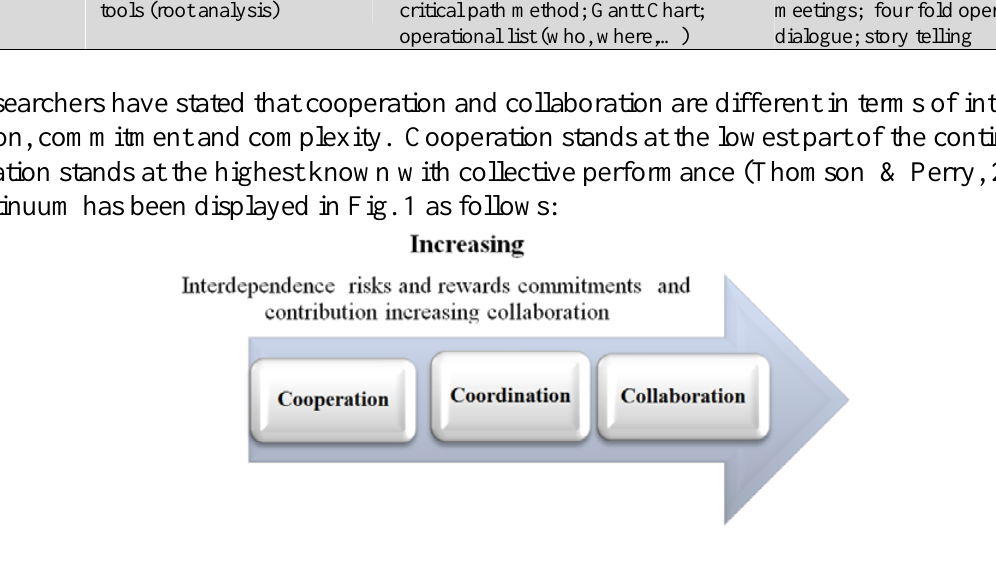
Fig.1. The collaboration continuum, based upon ARACY,